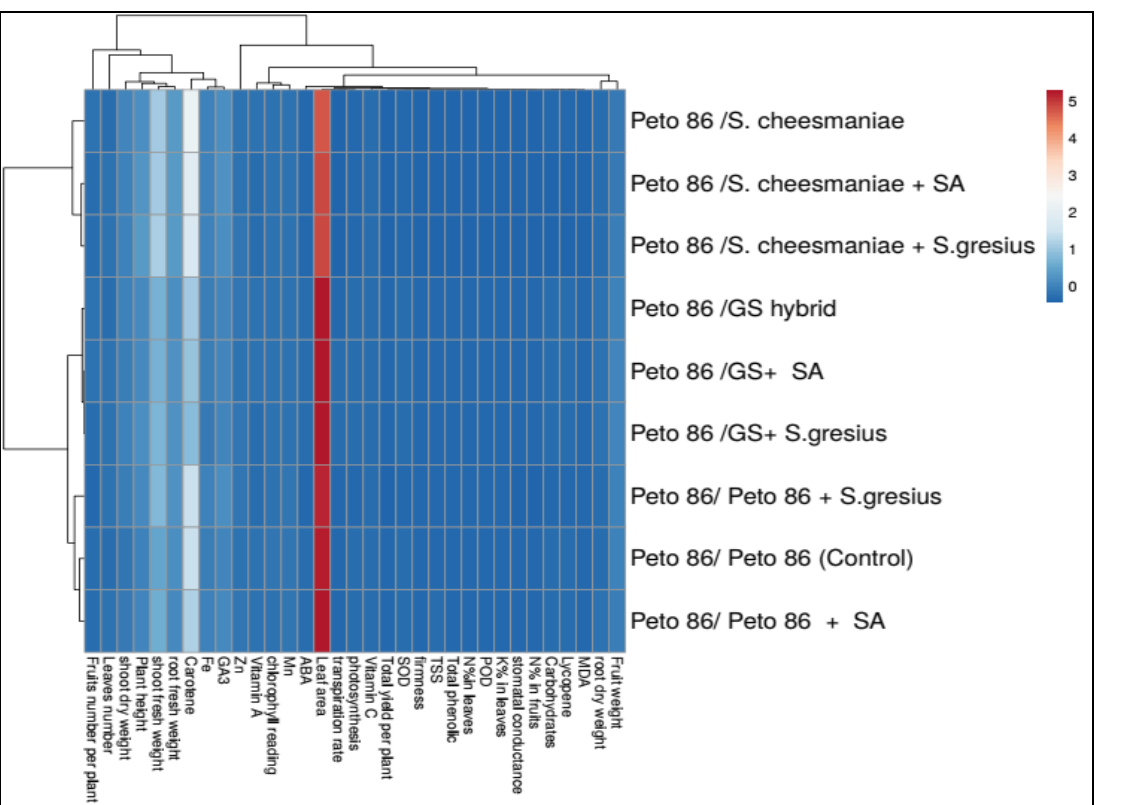
Figure 5. Heatmap of grafting, rootstock seeds treated with SA, and colonisation with S. griseus , and measured attributes of tomato plants. The heatmap diagram shows the variations in the response variables across all investigated treatments. Individual response variables are represented by columns, while treatments are represented by rows. According to the scale in the bottom right corner of the heatmap, lower numerical values are coloured blue and higher numerical values are coloured red.